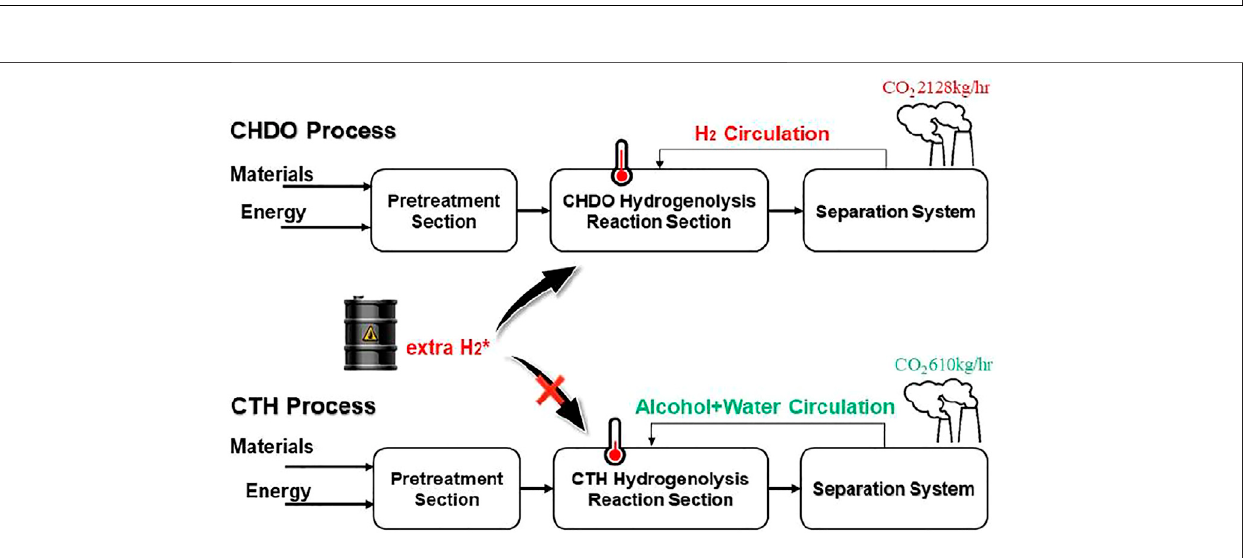
FIGURE 12 | The advantages of CTH compared with